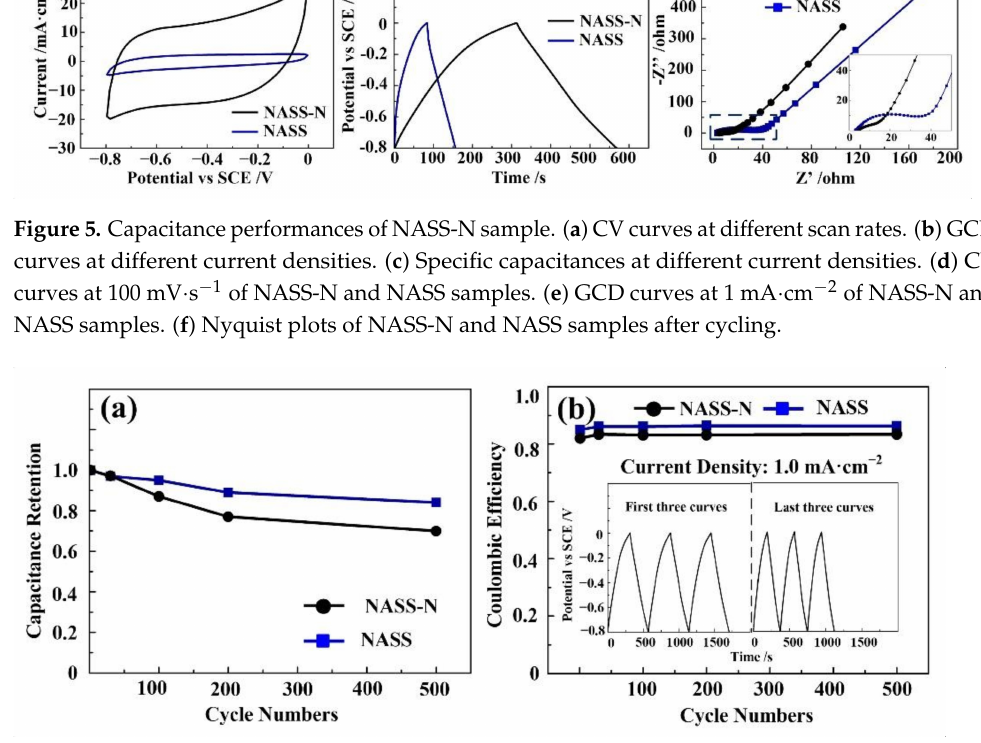
Figure 6. Cyclic performance of NASS-N and NASS samples at 1 mA · cm − 2 . ( a ) Cyclic stability. ( b ) Coulombic efficiency, inset shows the first and last three GCD cycles of NASS-N